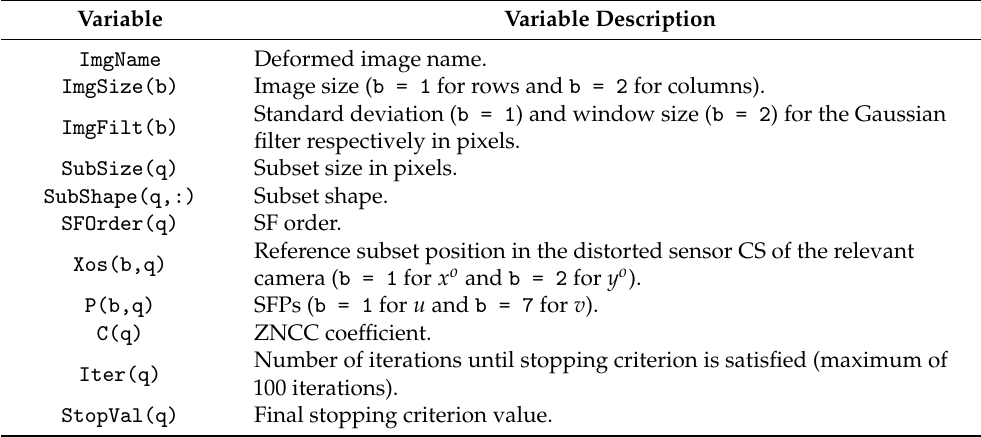
Table 3. Accessing the processing data for temporal matching ( ResultData.ProcData1(d)